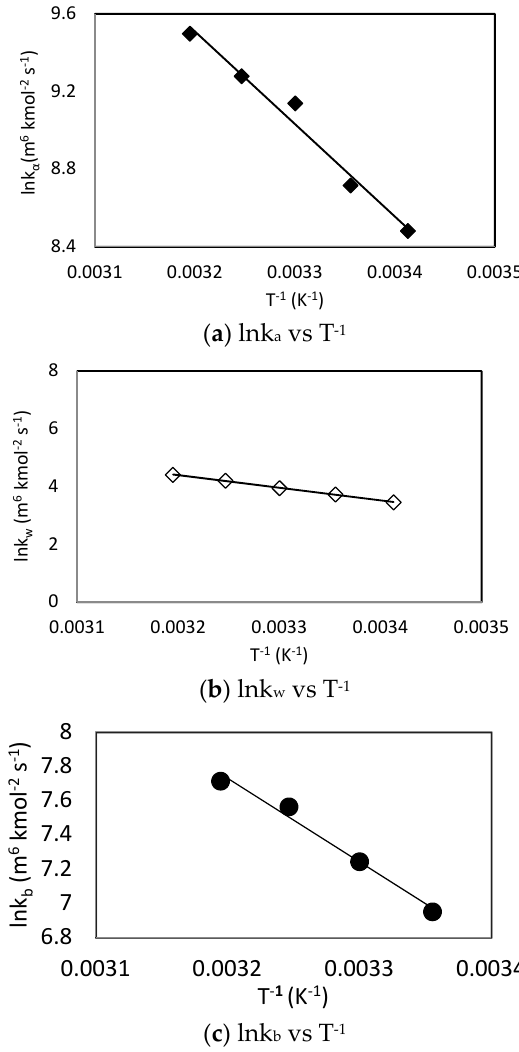
Processes 2018 , 6 , x FOR PEER REVIEW Figure 10. Arrhenius plots of CO 2 -MDEA-Arg rate constants using termolecular mechanism. Table 8. Reaction rate constants at different temperatures using termolecular mechanism.